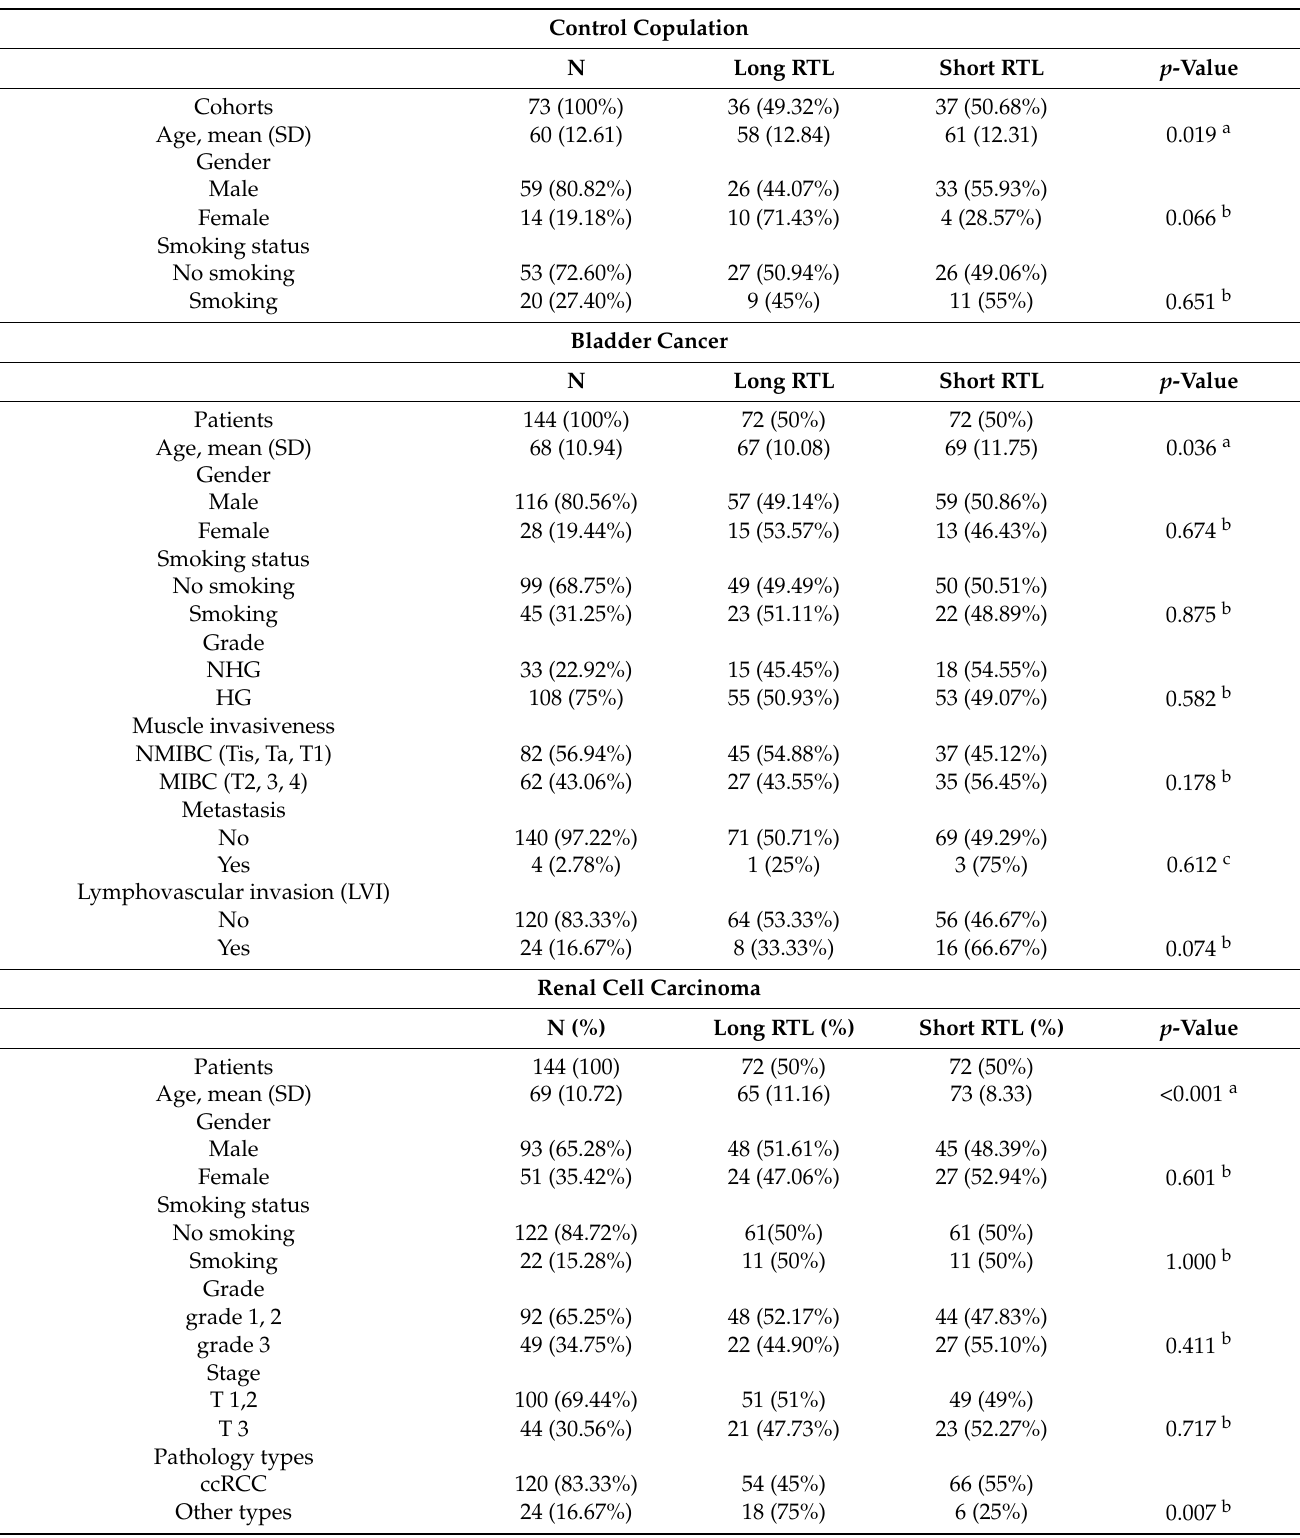
Table 1. Demographic and clinical characteristics of study population (bladder cancer and renal cell